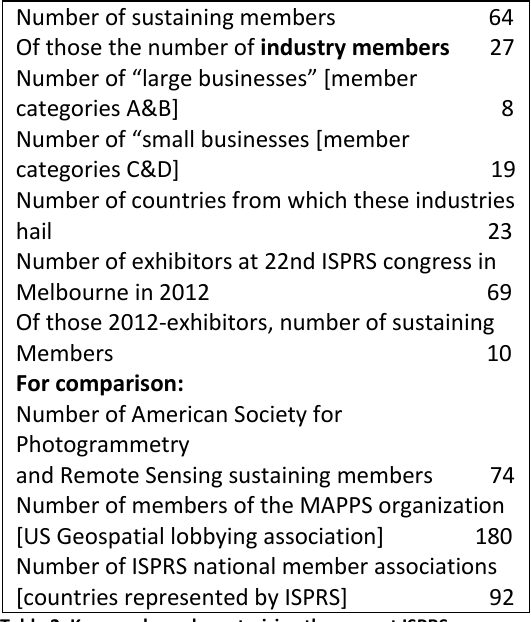
Table 2: Key numbers characterizing the current ISPRS sustaining membership ISPRS Presentation of Current Benefits from Sustaining Membership